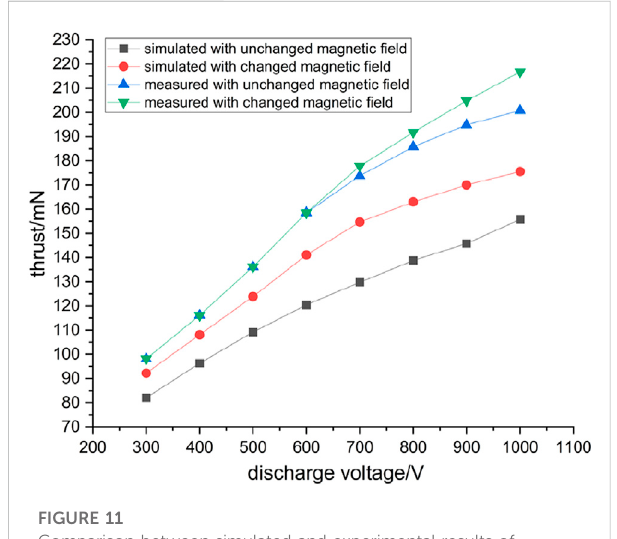
FIGURE 11 Comparison between simulated and experimental results of